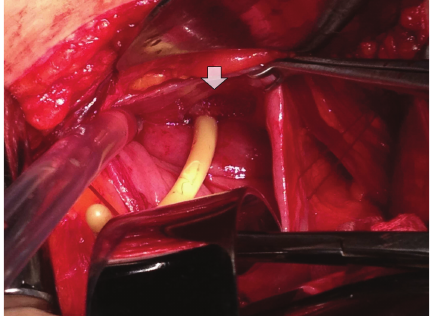
Figure1:Cystoscopicviewofthetapefromurethra,perforatingwall to wall of the bladder.